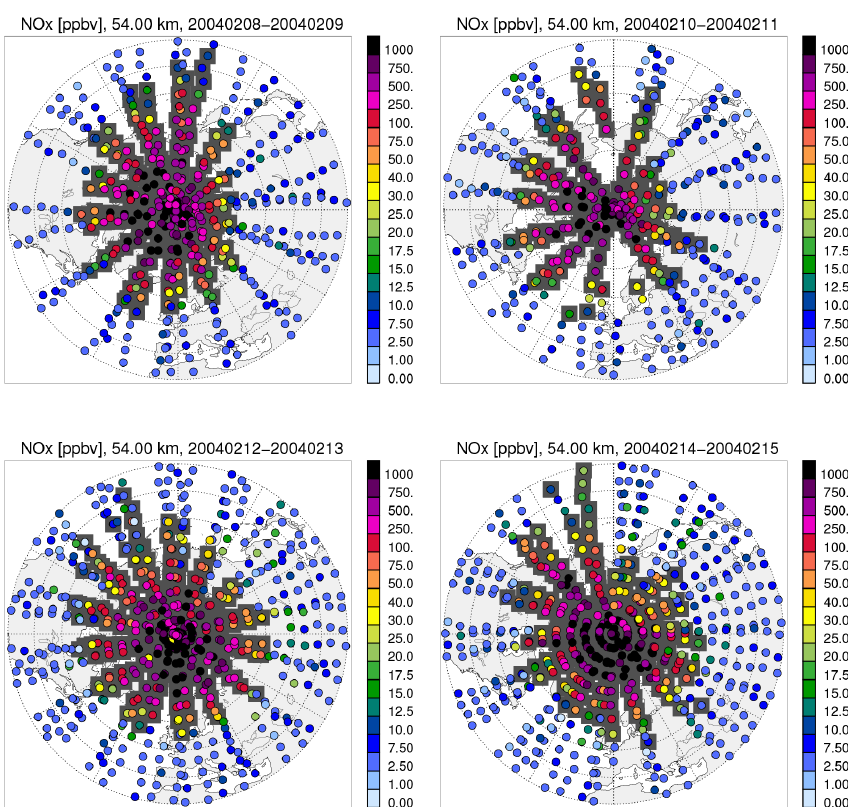
Figure 7. NO x (day and night) single observations from MIPAS at 54km altitude from 8 to 16 February 2004. Grey rectangles mark observations where the corresponding CO value was larger than 1ppmv marking, e.g., observations within the vortex.